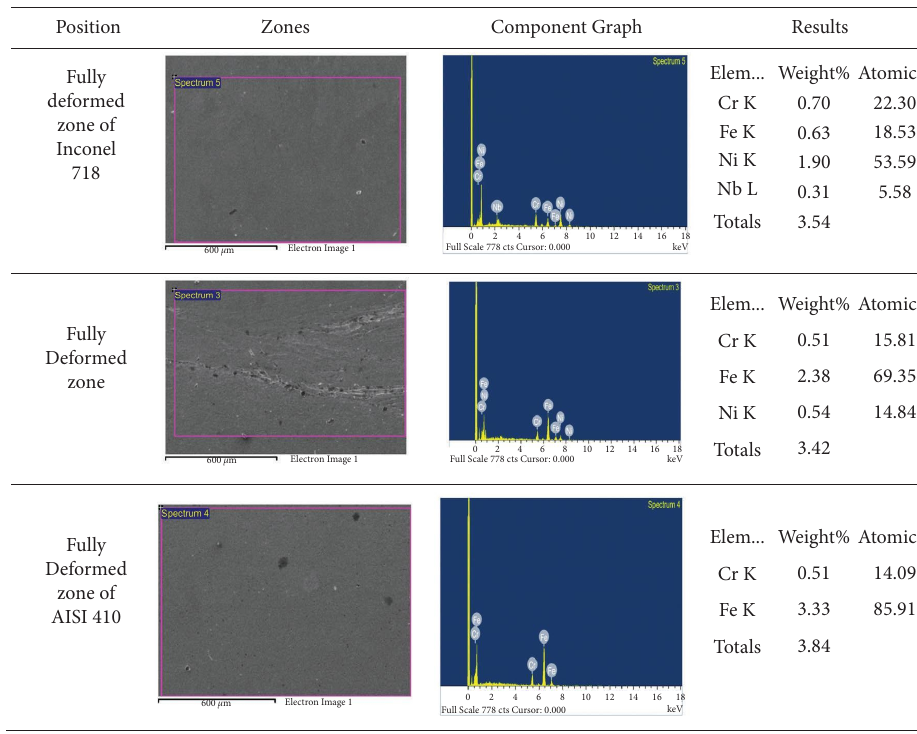
Figure 12: EDSSEM